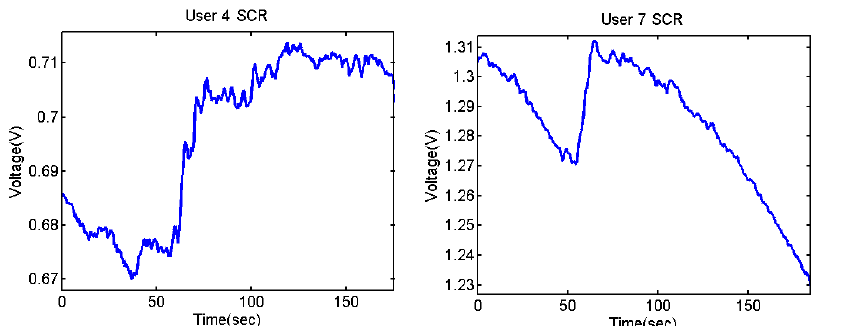
Figure 28. Skin response of users 4 and 7 from Stoop